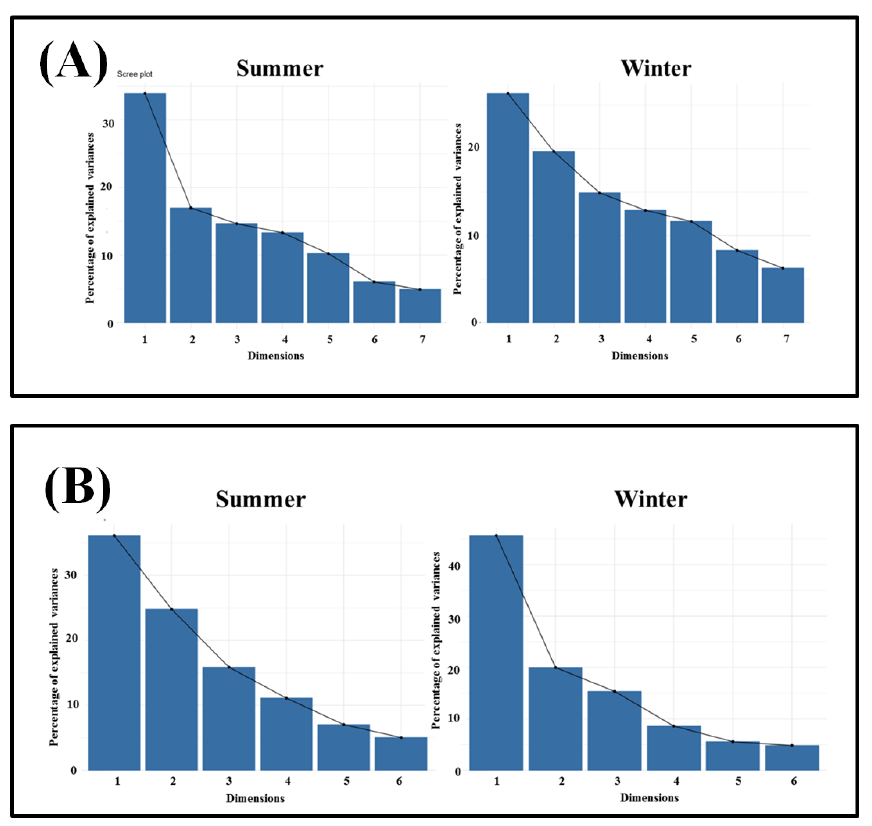
Figure 3. Percentage of variance explained by each principal component during summer (left) and winter (right) for the meteorological data ( A ) and air quality data ( B